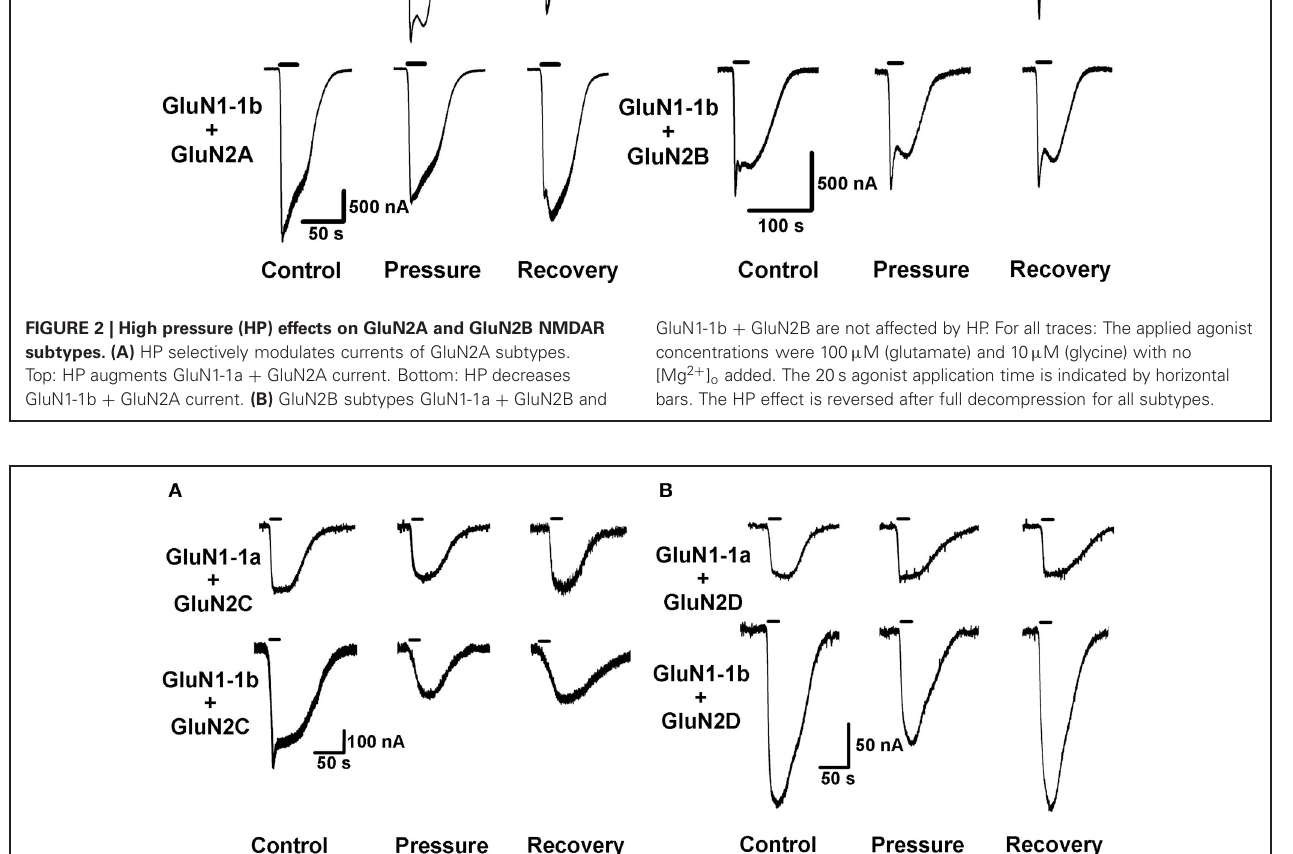
GluN2D seem to be “pressure-resistant.” Bottom: HP decreases GluN1-1b + GluN2D current. Note complete recovery after a full decompression. For all traces: the applied agonist concentrations were 100 µ M (glutamate) and 10 µ M (glycine) with no [Mg 2 + ] o added. The 20s agonist application time is indicated by horizontal